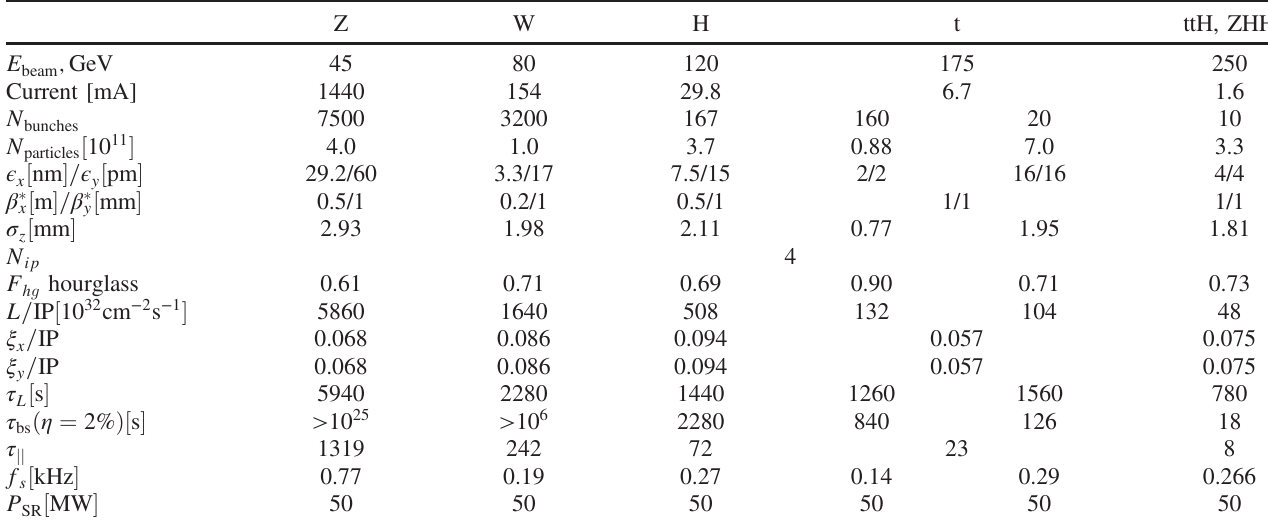
TABLE I. Main parameters from the 2013 workshop at CERN [4].